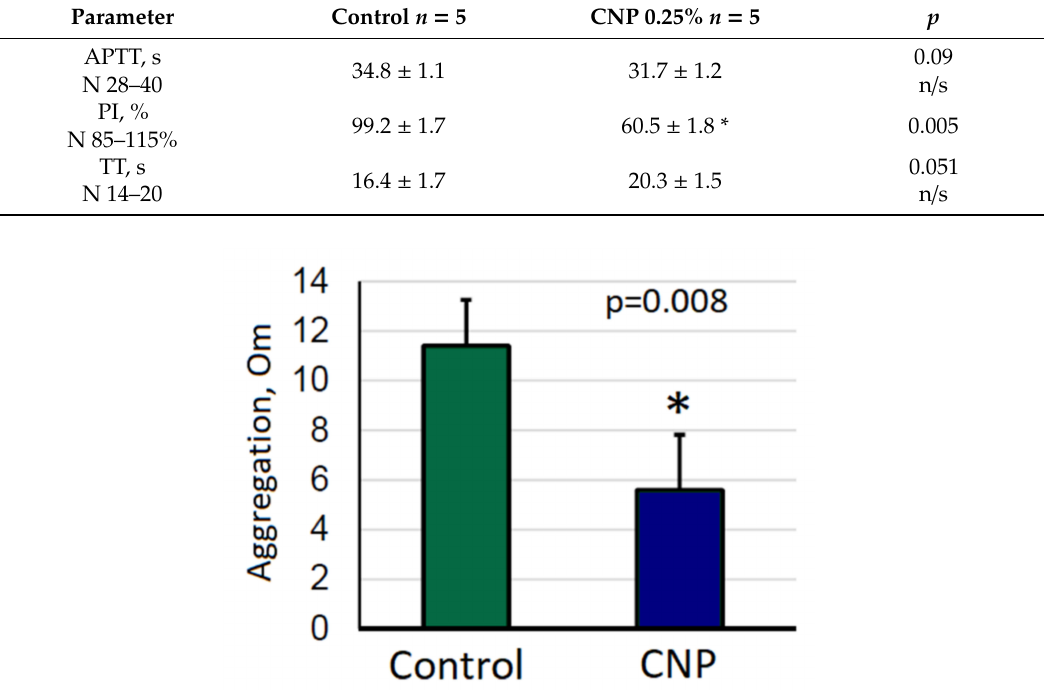
Figure 3. Platelet hemostasis in the ADP-induced platelet aggregation test with 0.12% CNP suspension added to human plasma. Mean ± standard error. In the ADP test, the CNPs significantly inhibited platelet aggregation in comparison with the control. * – p < 0.05 with respect to Control.